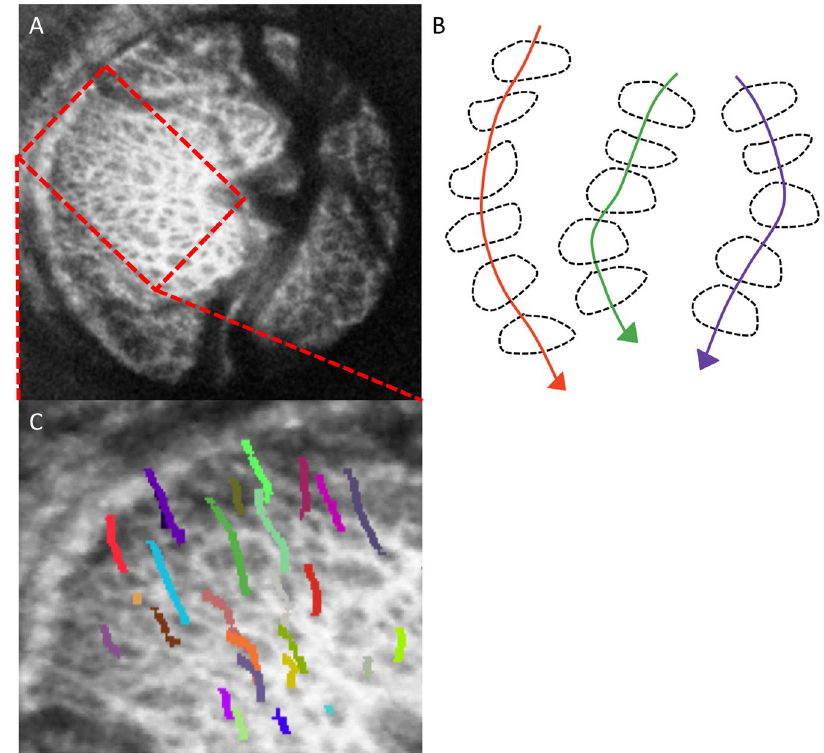
Figure 1. Pore path tracing. ( A ) Enface view of the lamina cribrosa. ( B ) Pore paths were traced with respect to depth via the centroid of the segmented pores. ( C ) 3D view of pore path tracing from a subset of pores in a single eye (27 out of 81).